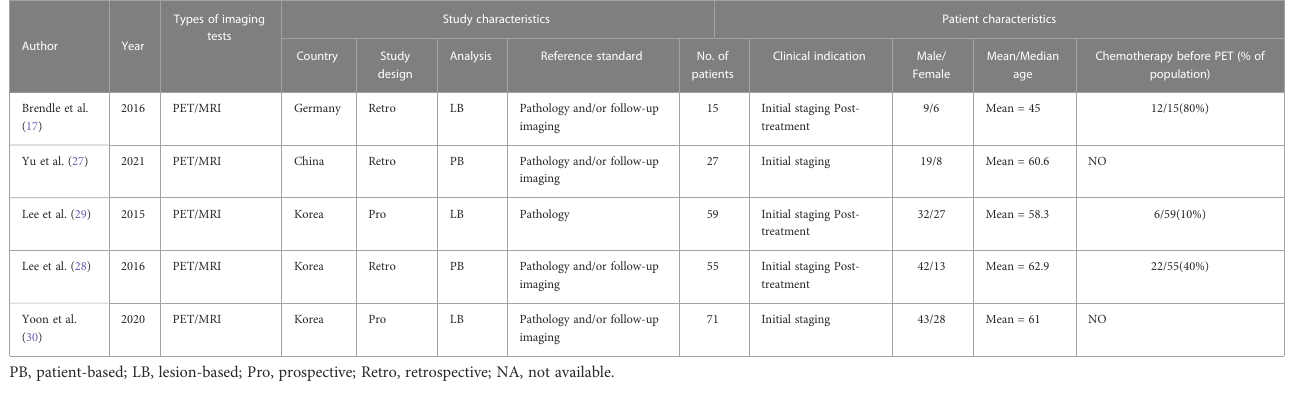
TABLE 2 Characteristics of the studies and patients for [18F]FDG PET/MRI.